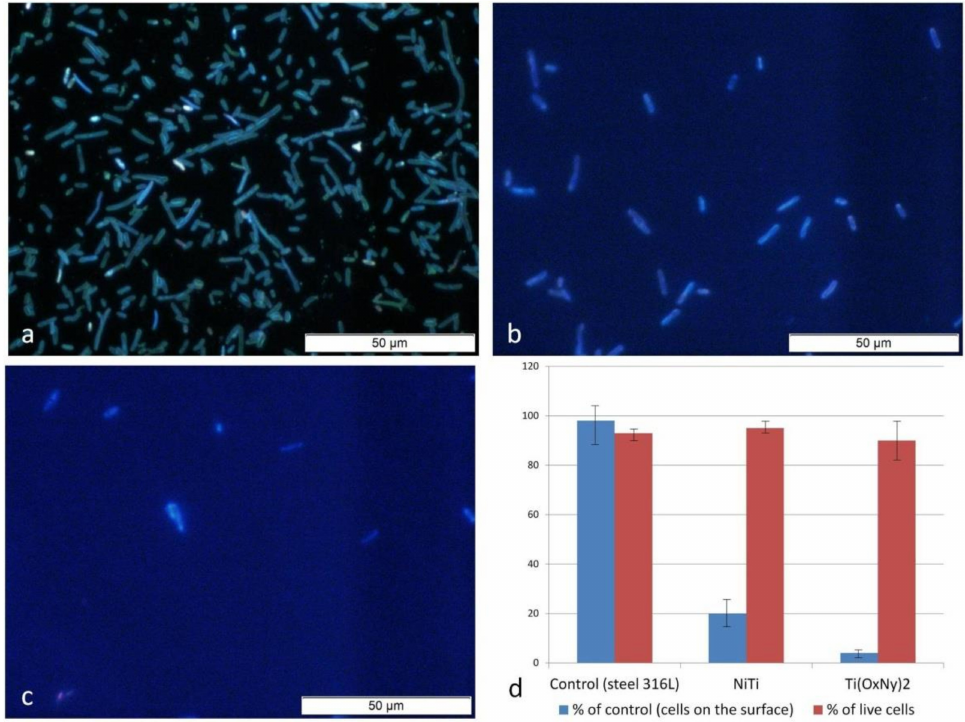
Figure 5. Images of E. coli cells cultured for 24 h on the control surface (316L steel) ( a ), the NiTi alloy surface in the initial state ( b ) and with a Ti(O x N y ) 2 surface layer ( c ), as well as the quantitative evaluation of colonization of the tested surfaces with E. coli bacteria in relation to the control and percentage of living cells ( d